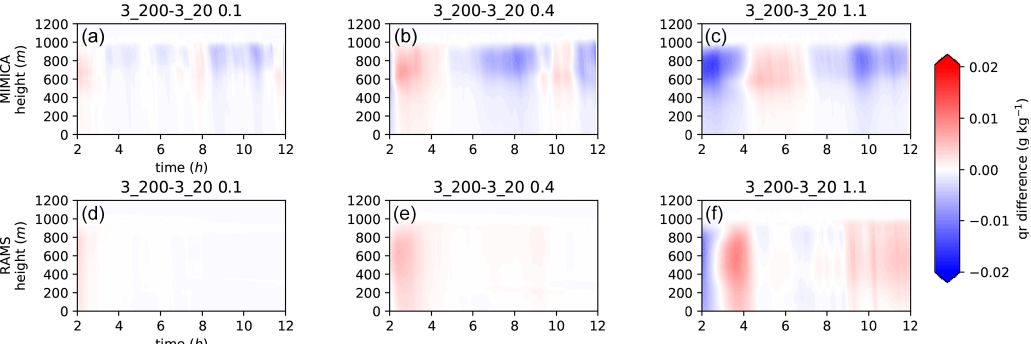
Figure A9. Differences in rain mixing ratio (qr) for simulation pairs with the same accumulation mode concentration and the same κ value of the Aitken mode particles equal to 0.1 (a, d) , 0.4 (b, e) and 1.1 (c, f) shown for MIMICA and RAMS. The first 2h of simulations, considered as the spin-up period, are excluded. A Student’s t test with a 95% confidence level shows that the (time mean) differences are statistically significantly different for each pair of simulations. For figure clarity, the plot titles have been abbreviated; the first number refers to the accumulation mode and the second to the Aitken mode concentration in cubic centimetres, i.e. 3_20 refers to AC3_AK20.